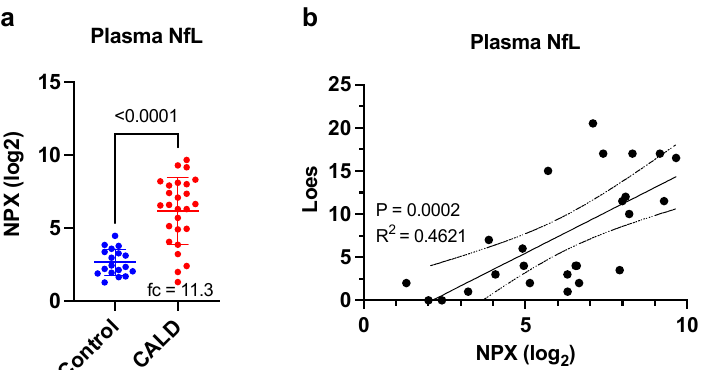
Figure 3. Elevated plasma NfL in CALD patients correlated with cerebral disease level. ( a ) Comparison of plasma NfL levels between CALD patients and a pediatric control group. NPX values determined from Olink Neurology Exploratory Panel. Fc indicated fold-change after conversion to linear scale. p -values are derived from a Student’s t -test. ( b ) Correlation between Loes score and plasma NfL. R 2 and p -values were derived from a simple linear regression. Dotted lines indicate the 95% confidence intervals.